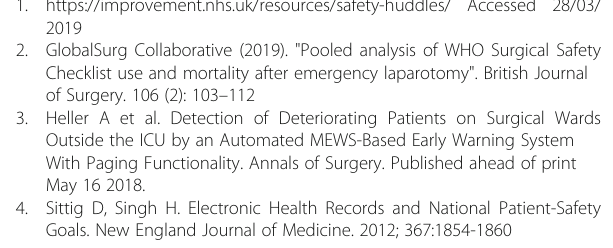
Table 1 (abstract 000156). Variables, predicting laboratory haemostasis disorders (thrombocytopenia in combination with increased INR)